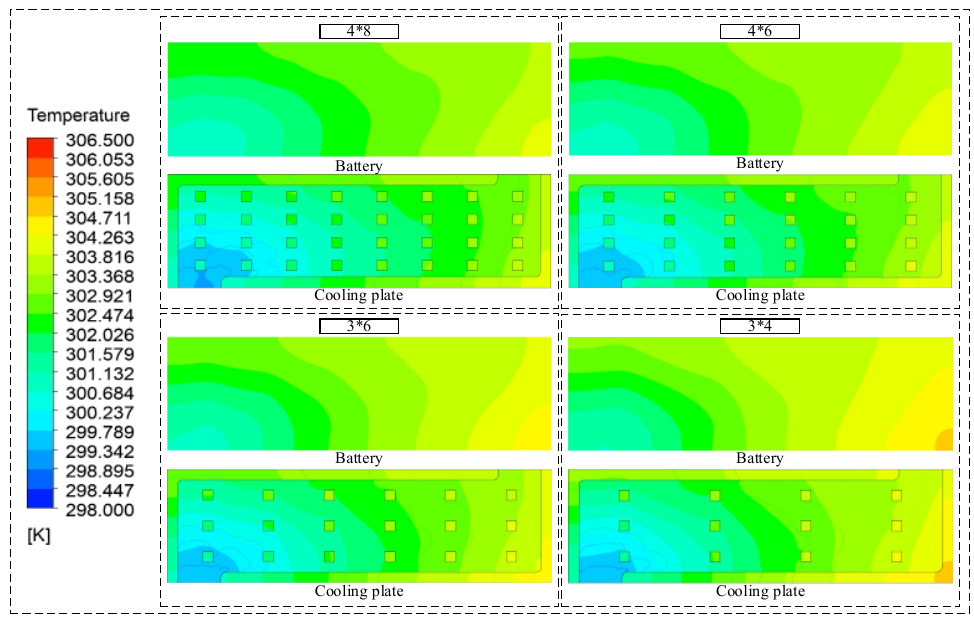
Figure 11. Temperature contour of battery and cooling plate with four numbers.